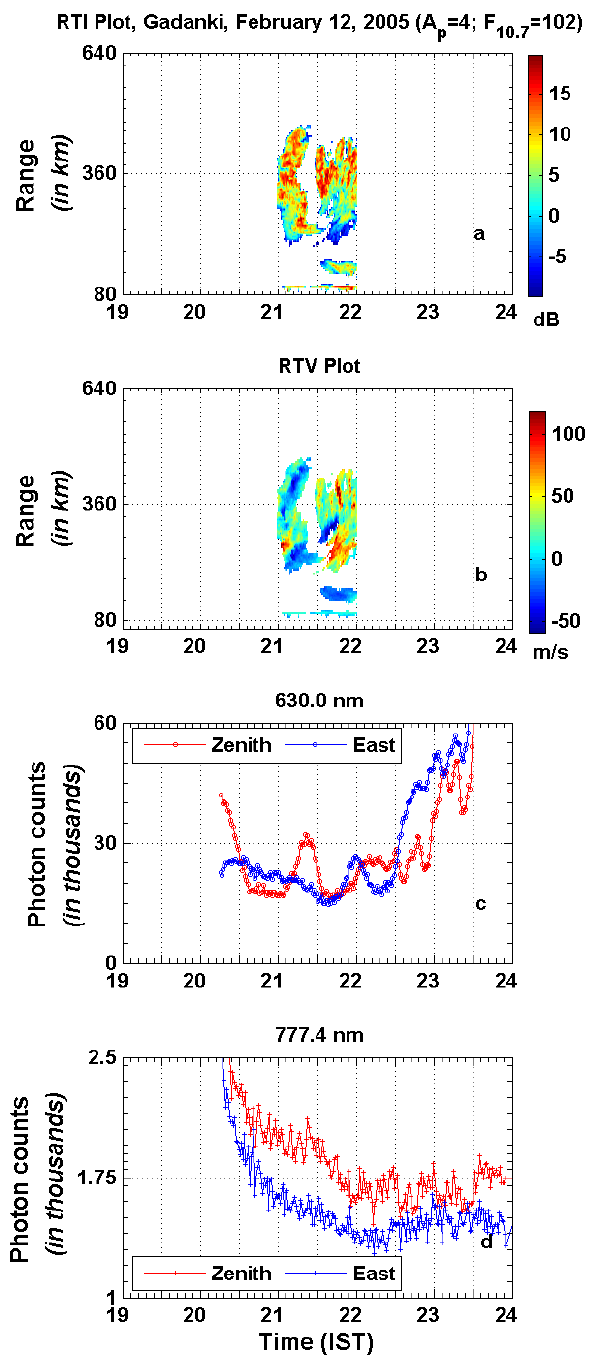
Fig. 7. Similar to Fig. 6 but for 12 February 2005 revealing isolated plasma plume structure. Please note that radar data are available during 21:00–22:00IST only.